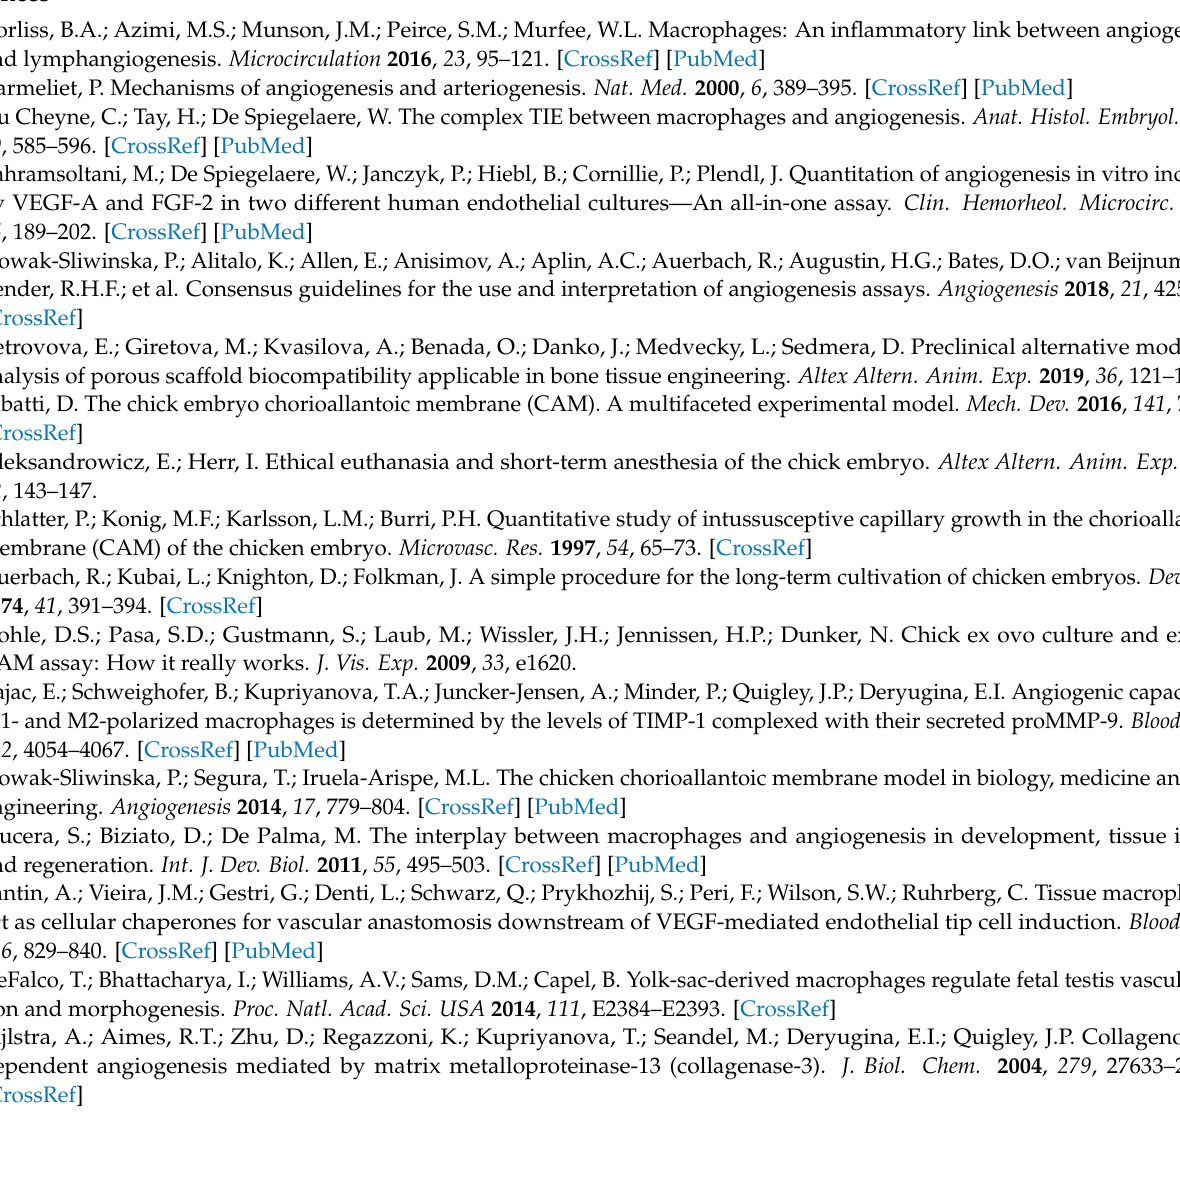
Figure S7: Injection with free clodronate did not have a significant effect on angiogenesis compared with injection with PBS. Statistical analysis using the Wilcoxon signed rank test revealed that no significant difference could be observed in the number of ingrowing capillaries in HT1080 plugs ( p = 0.97) as well as in plain collagen plugs ( p = 0.16). Data are presented as boxplots showing the median, first and third